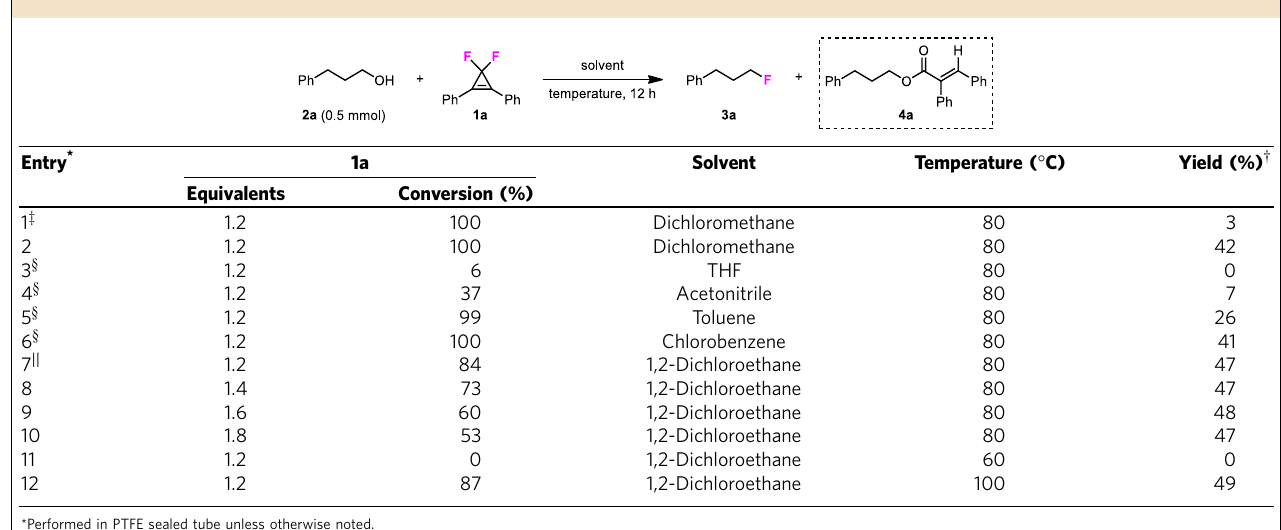
Table 1 | Initial deoxyfluorination of alcohols with CpFluor